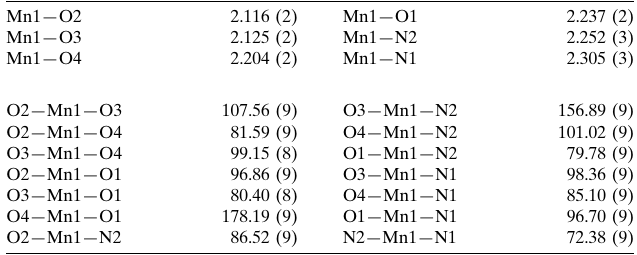
Selected geometric parameters (A˚ , (cid:2)